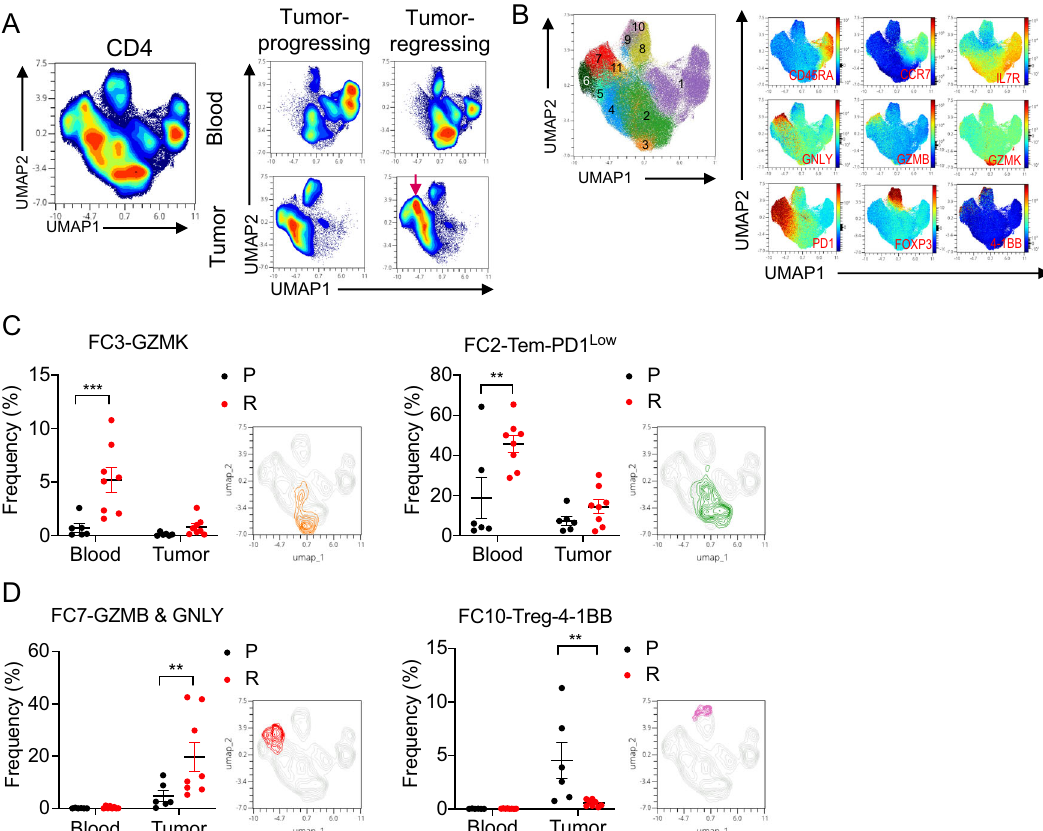
Fig. 4 Tumor control is associated with increased CD4 CTLs in blood and tumors. A Flow cytometry and dimensionality reduction analysis of CD4 T cells from blood and tumors of mice with tumor progression ( n = 6) and regression ( n = 8). The red arrow indicates a population enriched in regressing tumors. B Expression of selected T-cell lineage and functional markers across CD4 clusters. C Frequencies of clusters that are increased in the blood of tumor- regressing mice. D Frequencies of clusters that are increased in regressing tumors. The GZMK cluster is de fi ned by GZMK expression. The GZMB & GNLY cluster is de fi ned by GZMB and GNLY expression. The Tem-PD1 Low cluster is de fi ned by CD45RA − CCR7 − IL7R + PD1 Low . The results are shown as means ± SEM. ** p < 0.01, *** p < 0.001, two-way ANOVA, Sidak ’ s multiple comparison